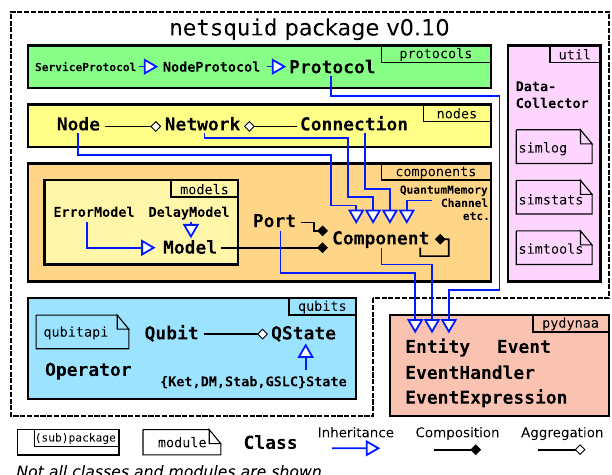
Fig. 10 Overview of NetSquid ’ s software architecture. The sub-packages that make up the NetSquid package are shown stacked in relation to each other and the PyDynAA package dependency. The main classes in each (sub-)package are highlighted, and their relationships in terms of inheritance, composition and aggregation are shown. Also shown are the key modules users interact with, which are described in the main text. In this paper NetSquid version 0.10 is